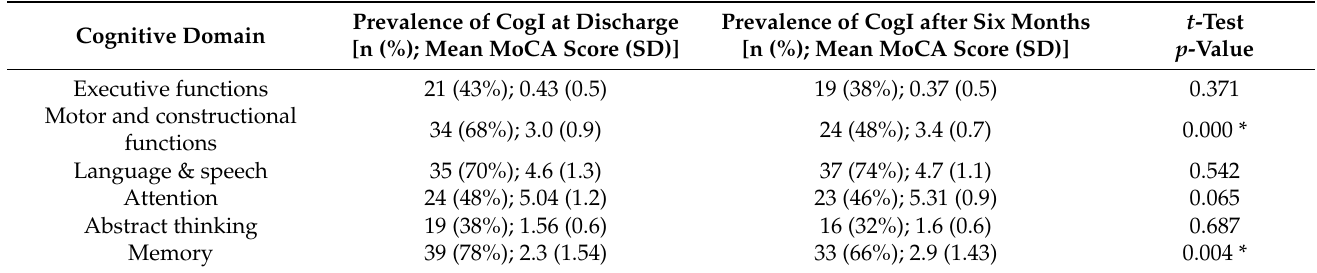
Table 2. Comparison of mean scores and prevalence of dysfunction in individual cognitive domains at discharge and 6 months after stroke.